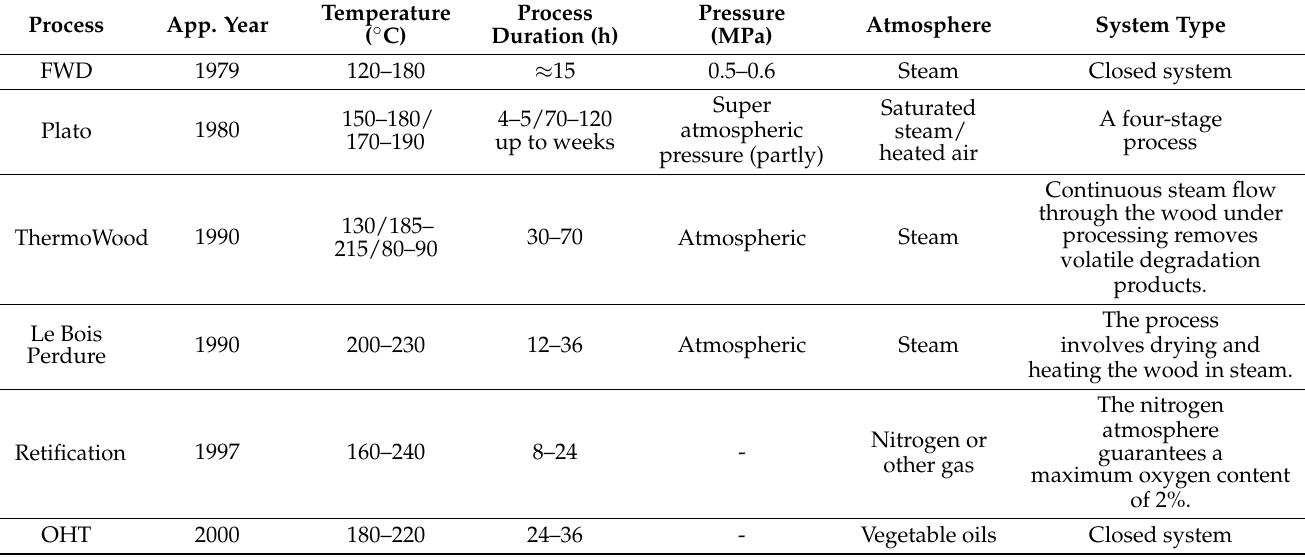
Table 1. Different thermal modification industrial processes (adapted from Sandberg et al. [18]).